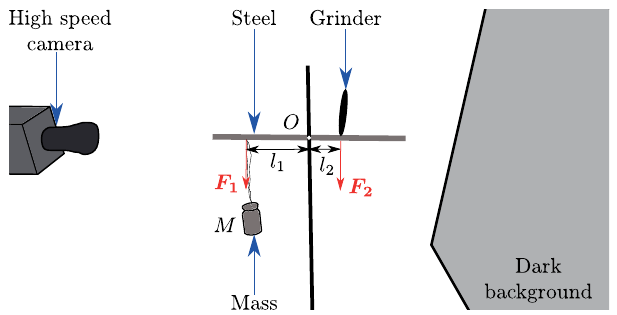
Fig. 1. Setup for sparks observation.